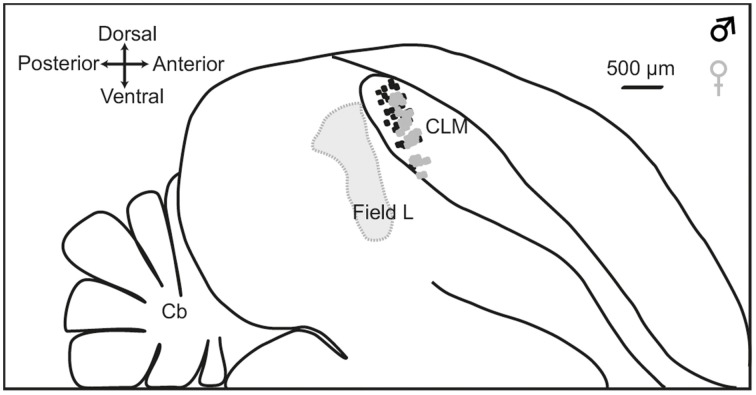
Location of recording sites. Outlines are traced from a parasagittal section at 1.2 mm from the midline. Dashed line indicates the boundary of Field L. The CLM region is located ventral to the lateral ventricle and dorsal to Lamina mesopallialis. Dots show the locations of recording sites based on coordinates taken during surgery within this parasagittal plane in males (black dots; number of recording locations, n = 56) and females (gray dots; number of recording locations, n = 60). CLM, caudal lateral mesopallium; Cb, cerebellum.